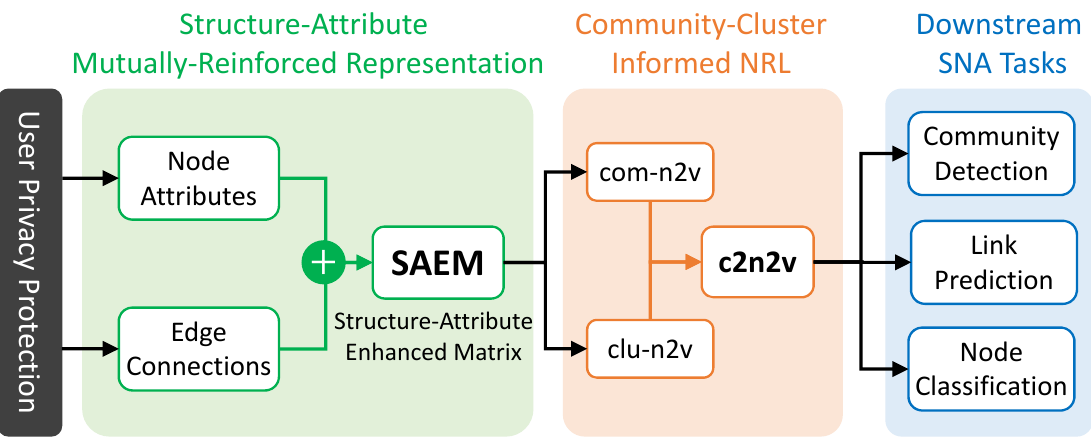
Figure 1. Flowchart of the proposed Network representation learning (NRL)